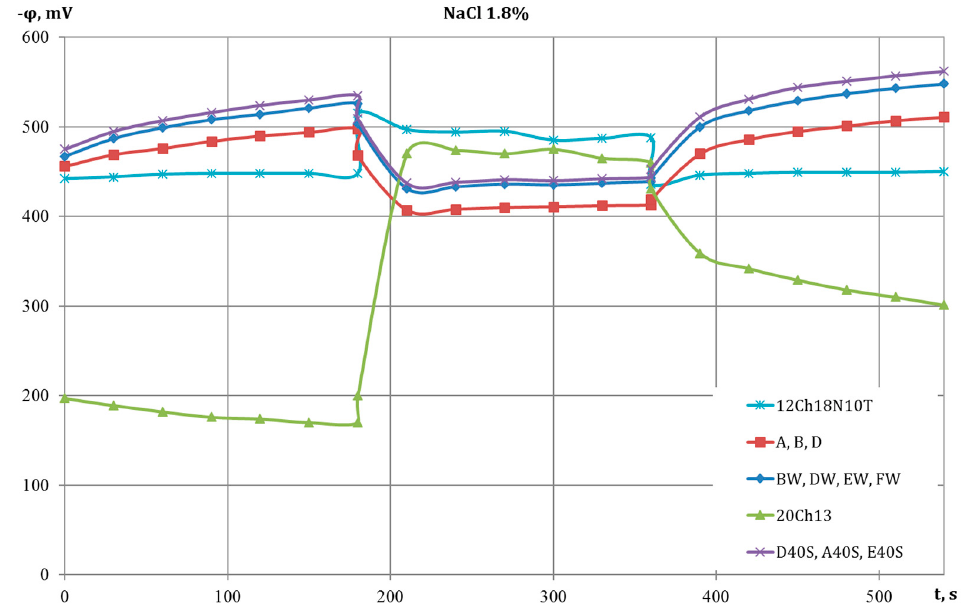
Figure 2. The first part of the experiment. Results.